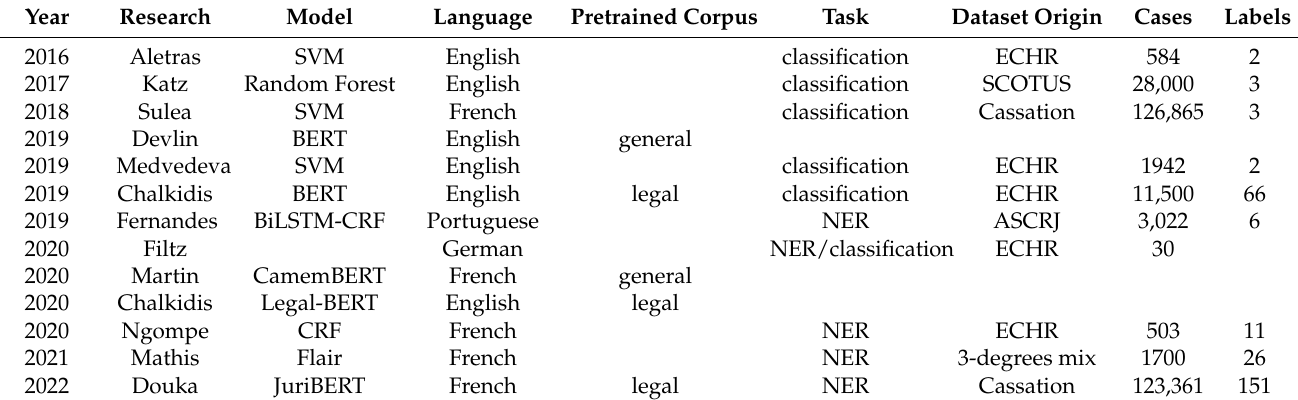
Table 1. Studies on court case data